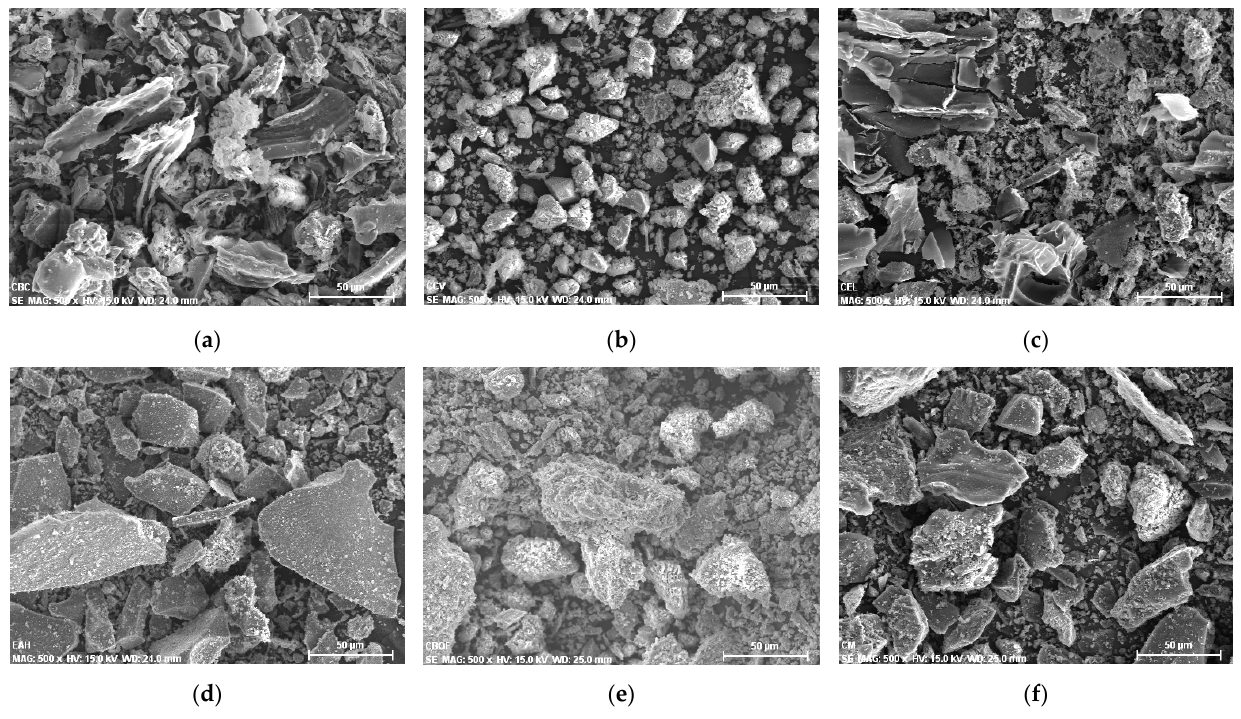
Figure 6. SEM images of the substitution materials. ( a ) SBA; ( b ) CA; ( c ) BMA; ( d ) BFA; ( e ) BA; ( f ) C.